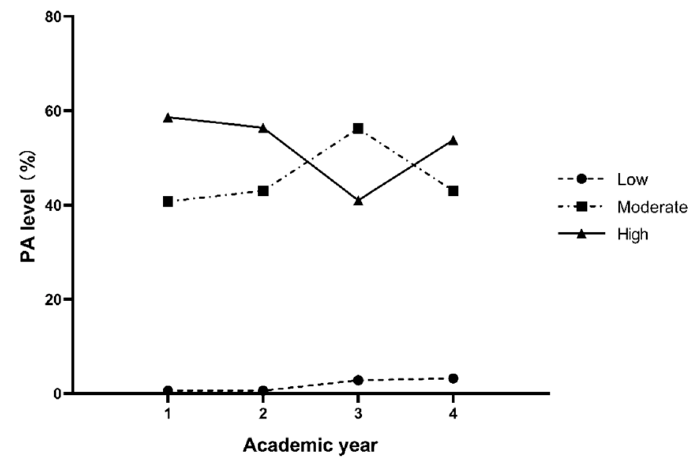
Figure 1. The percentages of the three levels of PA in each academic year for males.